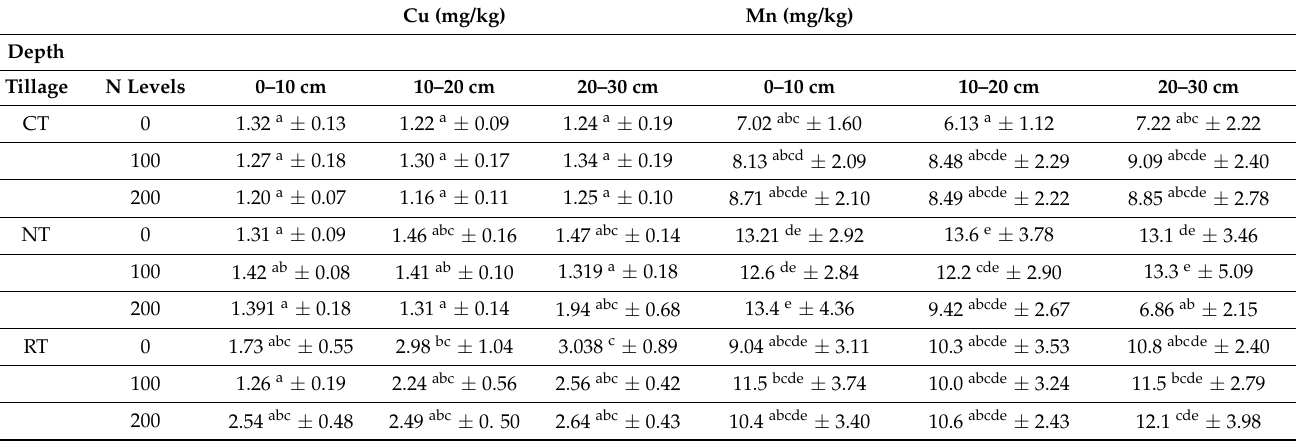
Table 4. Mean extractable copper (Cu) and manganese (Mn) (mg/kg) and standard errors of means found at different tillage treatments, sampling depths, and different N fertilizer application rates. Cu (mg/kg) Mn